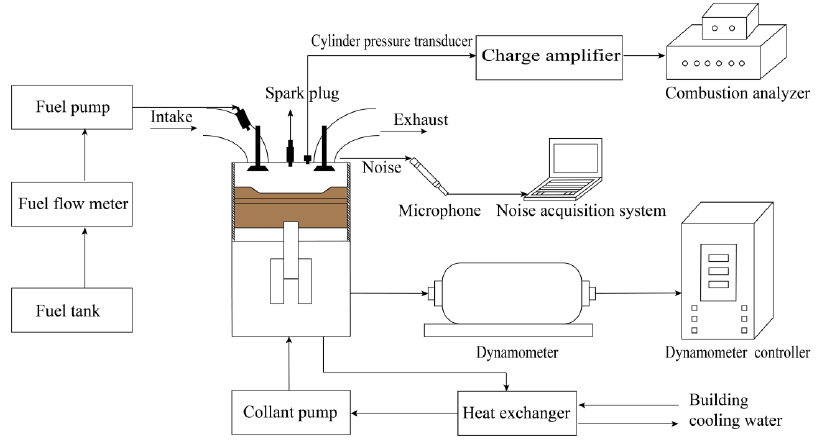
Figure 1. The schematic diagram of the experimental bench.